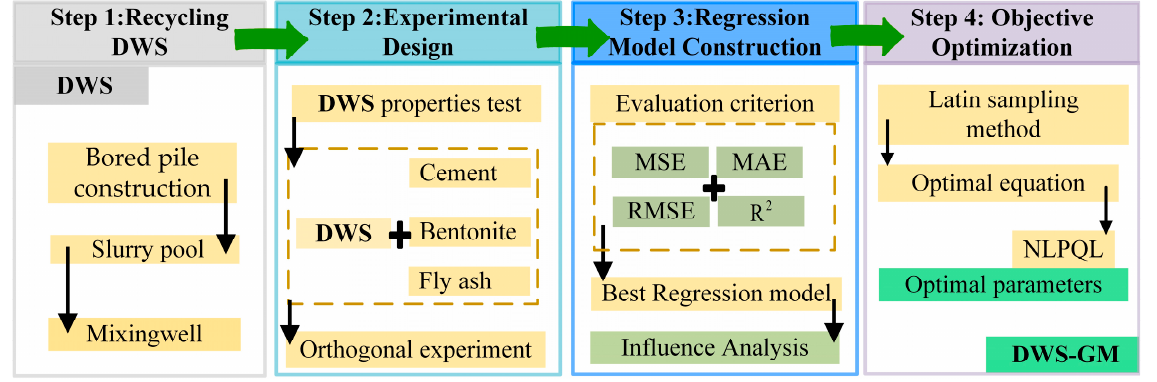
Figure 5. Technical route for converting reused DWS to DWS-GM.